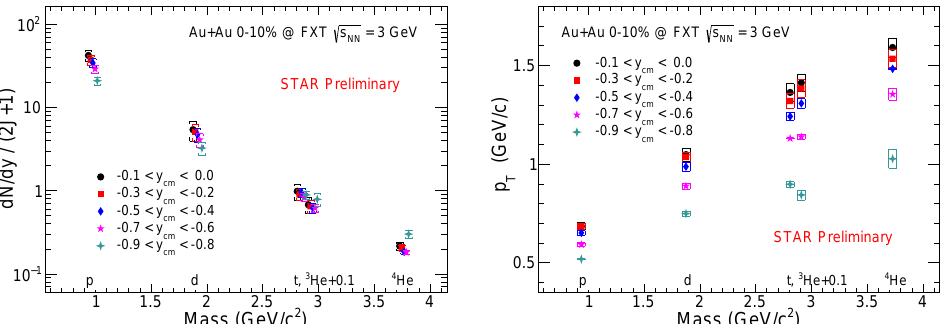
Figure 3: (left) dN / dy as an exponential function of particle mass at 0-10% cen- tral collisions from different rapidity windows, (right) 〈 p particle mass at 0-10% central collisions from different rapidity windows within the